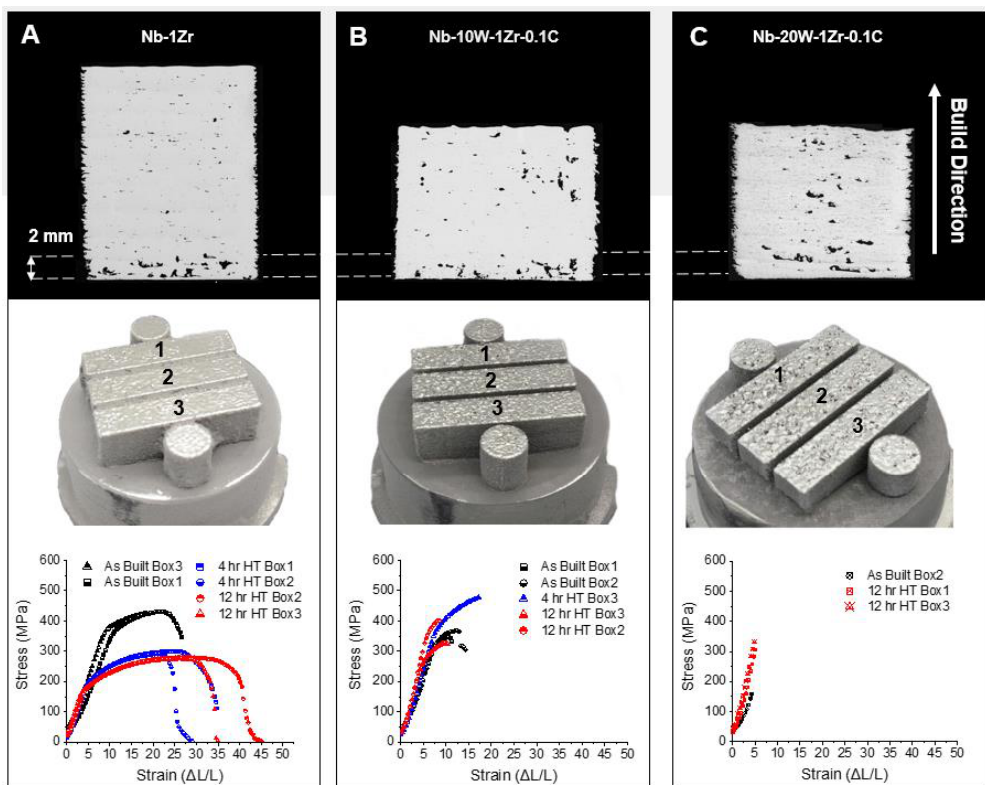
Figure 12. Optical micrographs of tensile build witness cylinders, tensile build photos, and corresponding properties for ( A ) Nb-1Zr, ( B ) Nb-10W-1Zr-0.1C, and ( C ) Nb-20W-1Zr-0.1C builds in the as-built and heat-treated (1200 °C) condi- tions.